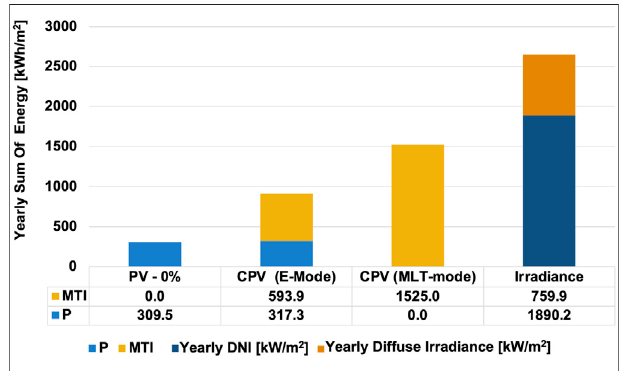
FIGURE 8 | Output Streams of the different modes and